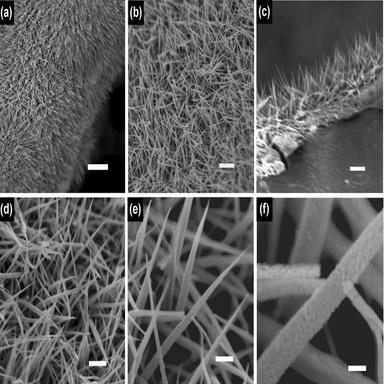
Low magnification SEM images of the MgCo2O4 nanoneedle arrays/Ni foam (aec), scale bar ¼ 6 mm, 1 mm, 1 mm, respectively. High magnification SEM images of MgCo2O4 nanoneedle arrays/Ni foam (def), scale bar ¼ 500 nm, 200 nm, 60 nm.